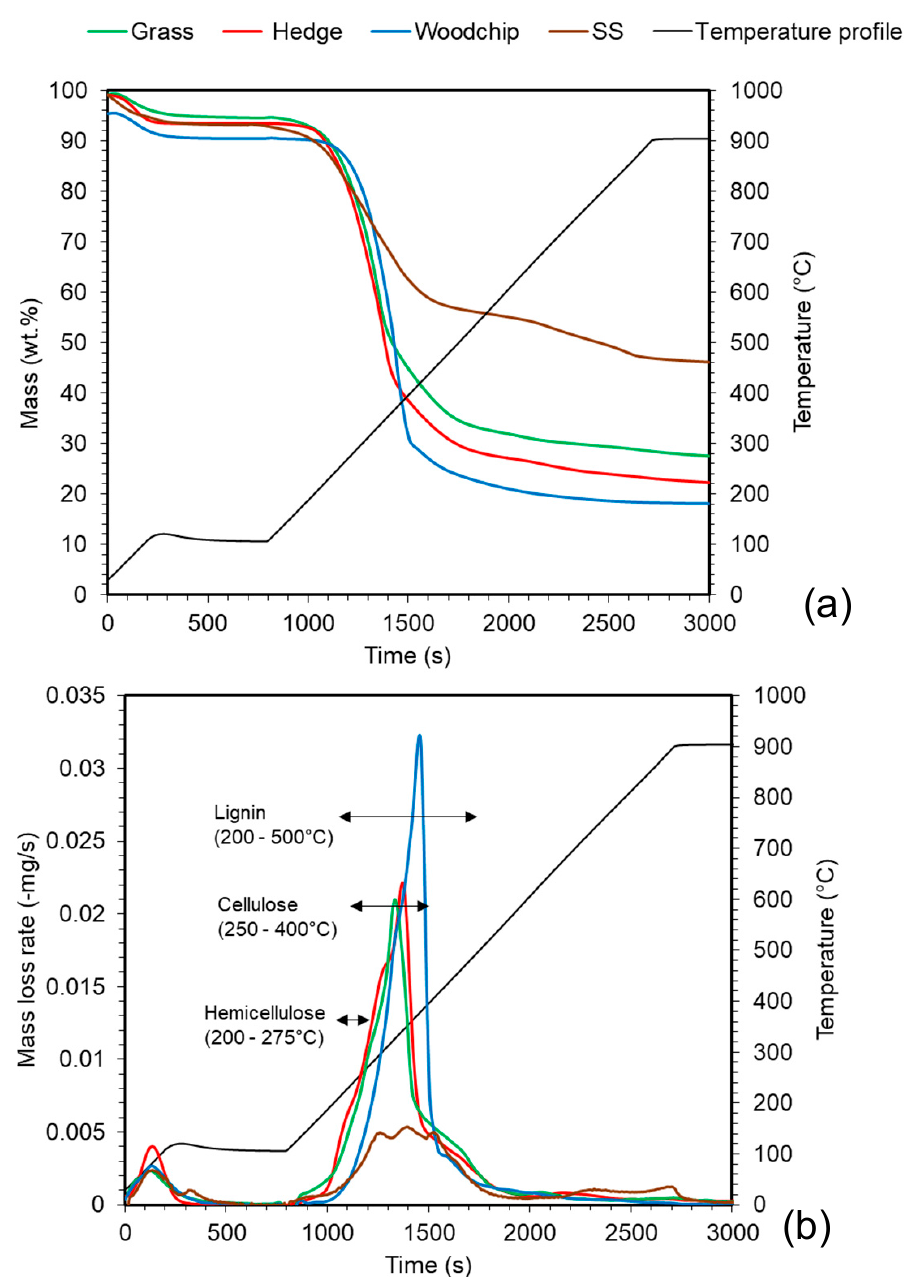
Figure 2. ( a ) TGA and ( b ) DTG curves for SS digestate and lignocellulosic biomass.